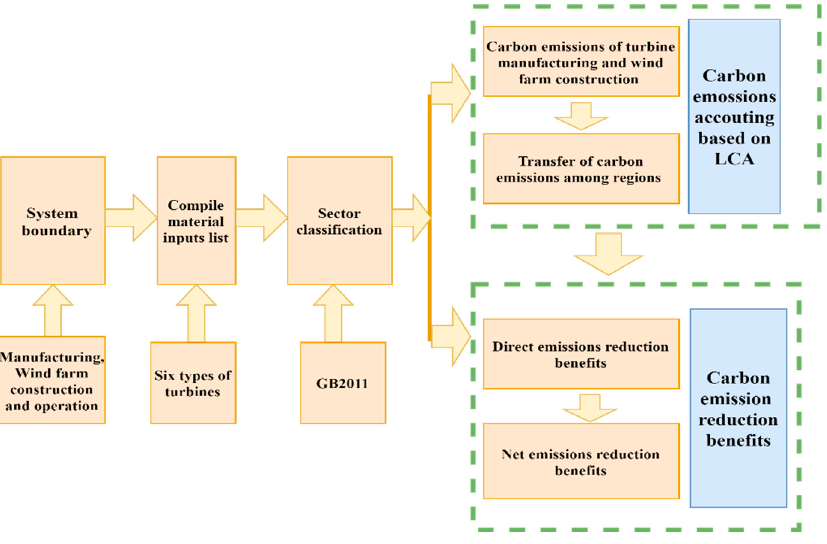
Figure 1. Methodological framework .